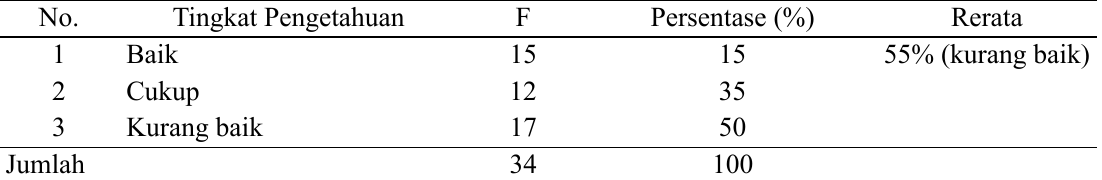
Tabel 5. Distribusi frekuensi pengetahuan (sintesis) lansia tentang nutrisi di Posyandu lansia